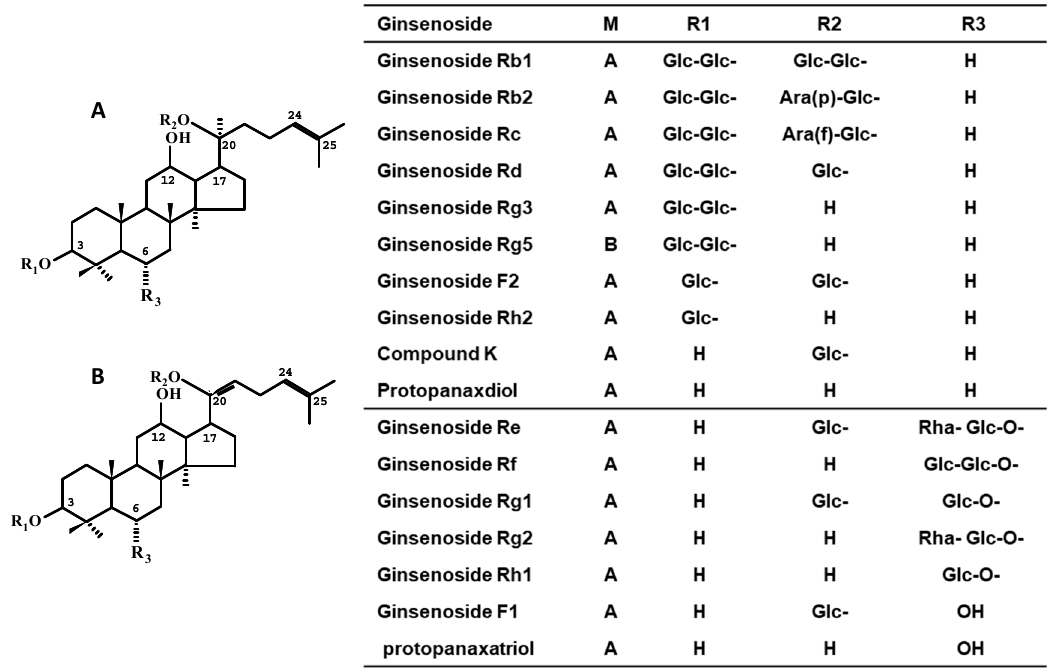
Figure 1. The Representative Ginsenosides Contained in WG and RG.